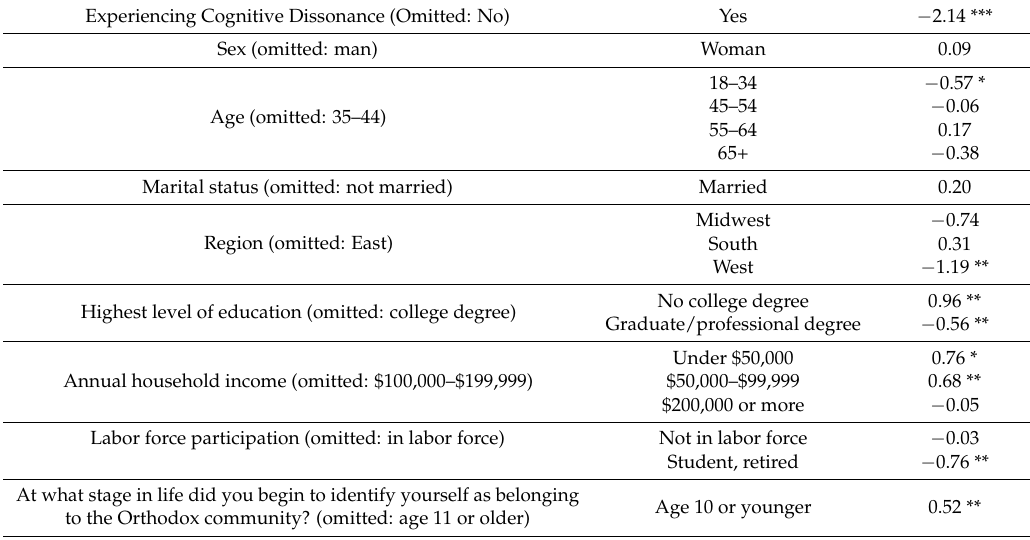
Table 7. Linear regression of Orthodox Jewish belief index on experiencing cognitive dissonance and sociodemographic characteristics